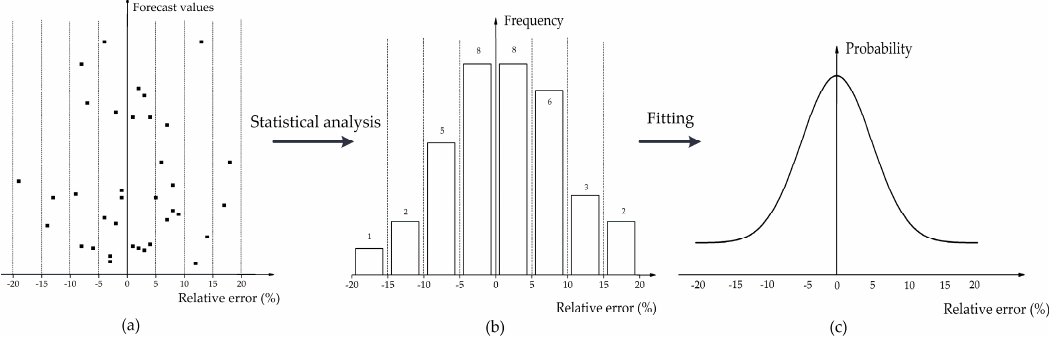
Figure 2. Schematic diagram deriving the method of relative error distribution of the forecasted runoffs. ( a ) Scatter plot of relative error; ( b ) frequency histogram of relative error; ( c ) principle of maximum entropy distribution curve.